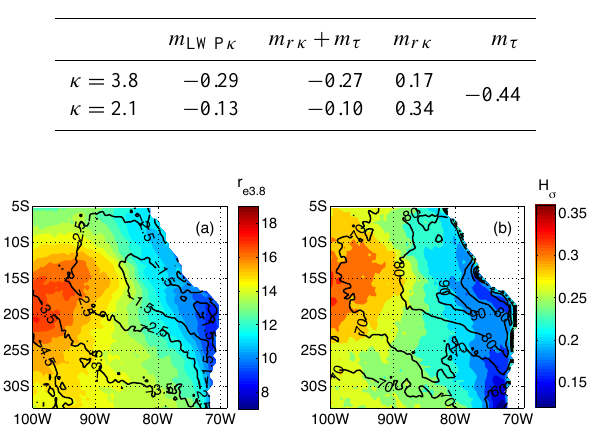
Table 1. MODIS fractional changes relative to fractional changes in H σ , Eq. (2).